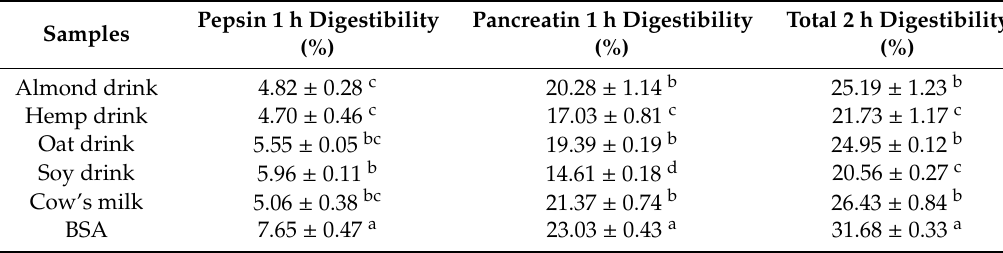
Table 3. In vitro protein digestibility (IVPD) of selected commercial plant-based milk alternatives and bovine serum albumin (BSA) 1